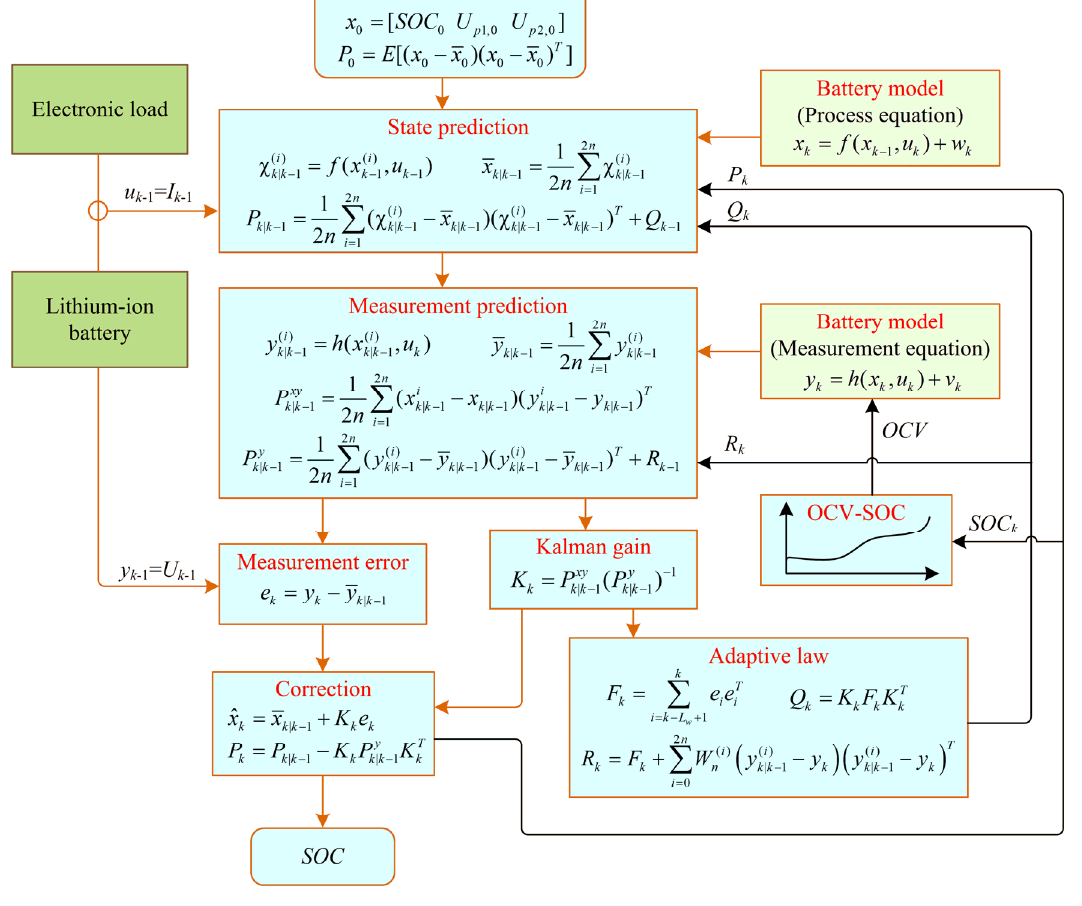
Figure 7. Schematic of the ACKF (adaptive cubature Kalman filter)-based SOC estimation algorithm. The schematic diagram of the proposed ACKF-based SOC estimation algorithm is shown in Figure 7. After initialization, the estimated state vector ˆ x and the estimation error covariance P k can k be firstly achieved according to the prediction and update processes. The voltage residual error e k is computed on the basis of the measurement equation of the battery model. Afterwards, the process noise covariance Q k and the measurement noise covariance R k are obtained though the voltage residual-based updating law. Then, ˆ x , P k , Q k and R k are used for the next prediction and update k processes. The battery SOC can be recursively estimated by repeating the above